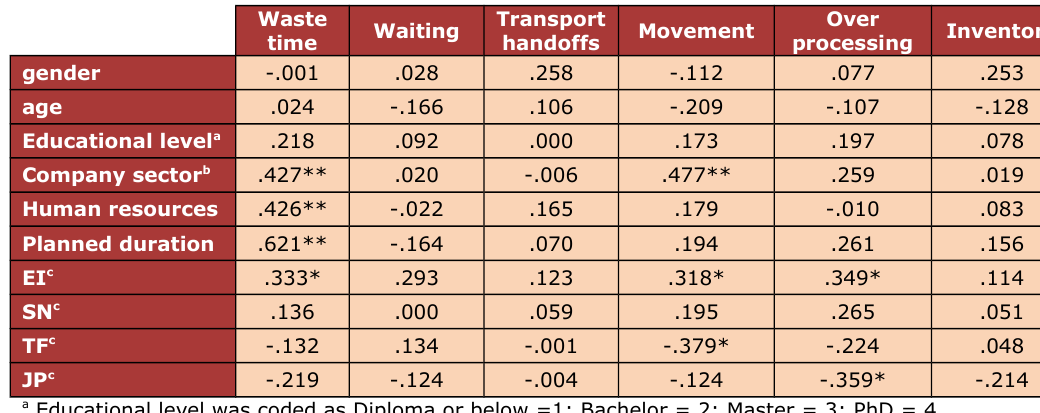
Table 4. Correlations between variables and traditional performance indexes